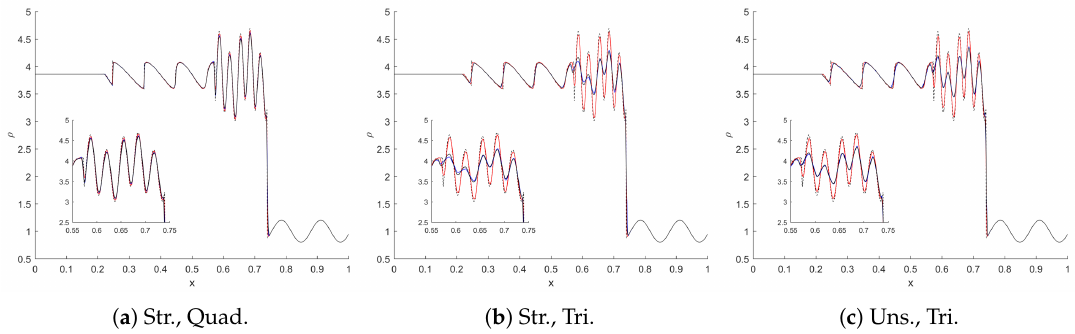
Figure 7. Two-dimensional Shu–Osher problem with β 0 = 1.00. The dashed black line is the reference solution and the solid red, blue, black lines are interpolated solutions with 1,201 equidistant points for n = 2,3, and 4 elements,